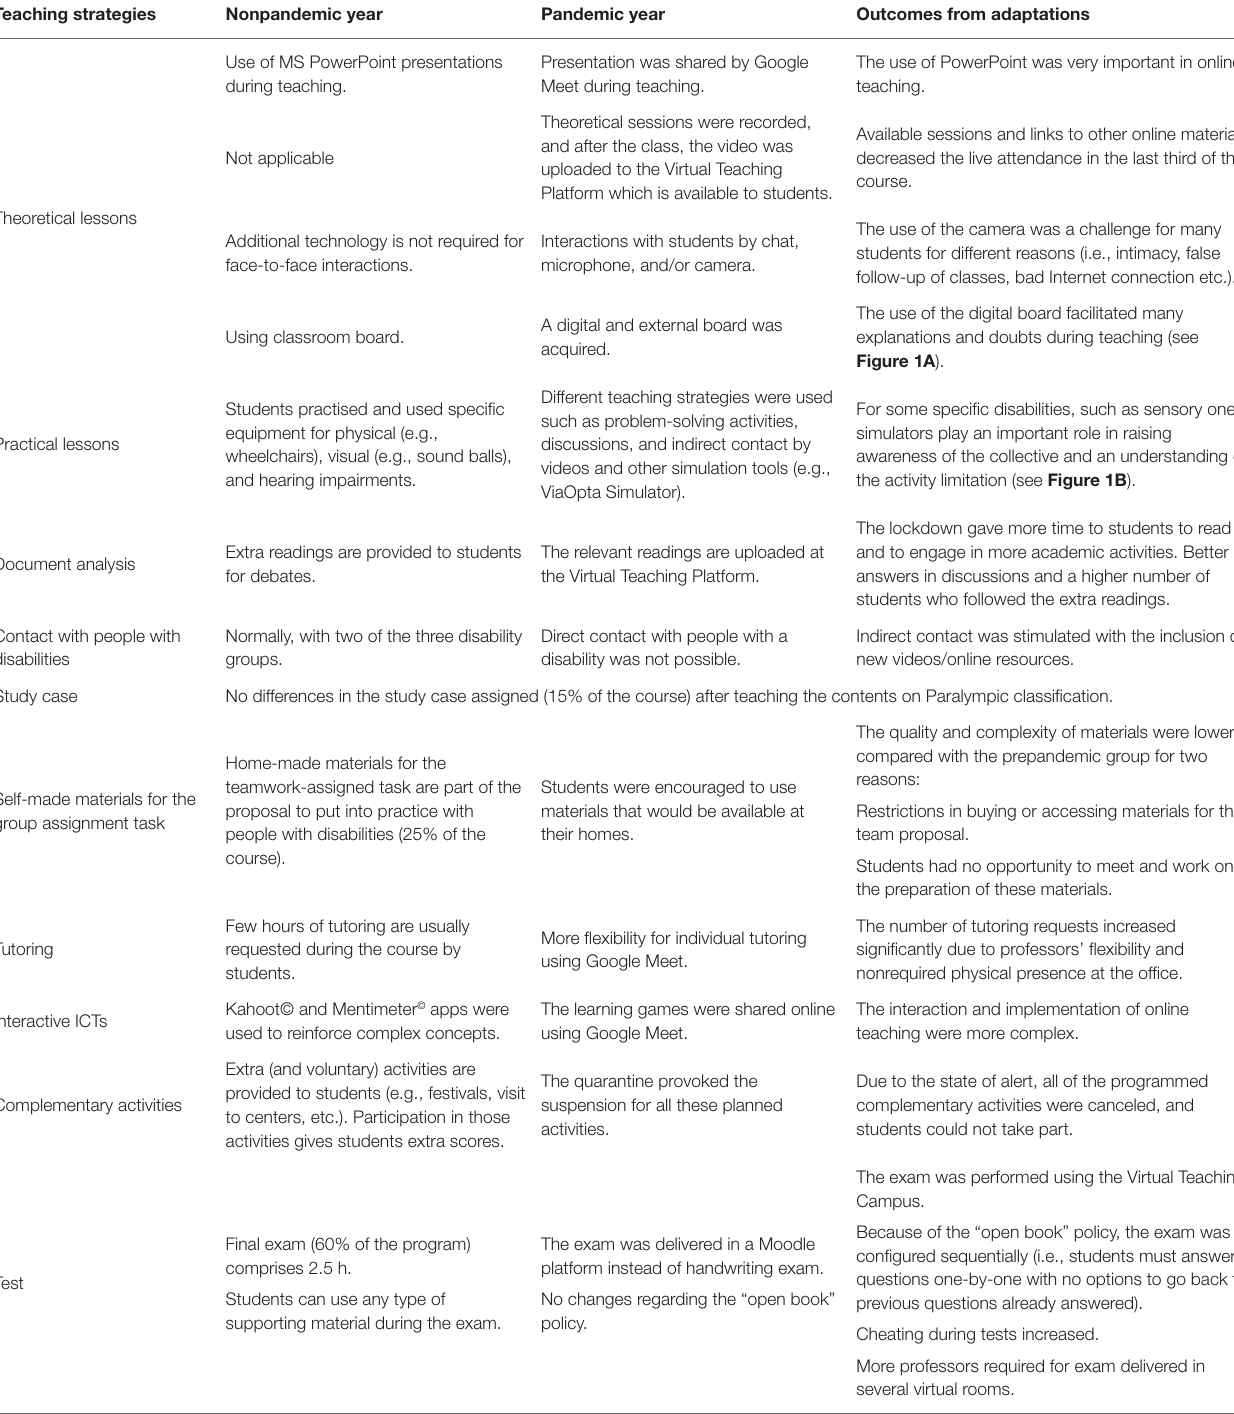
TABLE 3 | Differences for teaching delivery provoked by the SARS-CoV-2